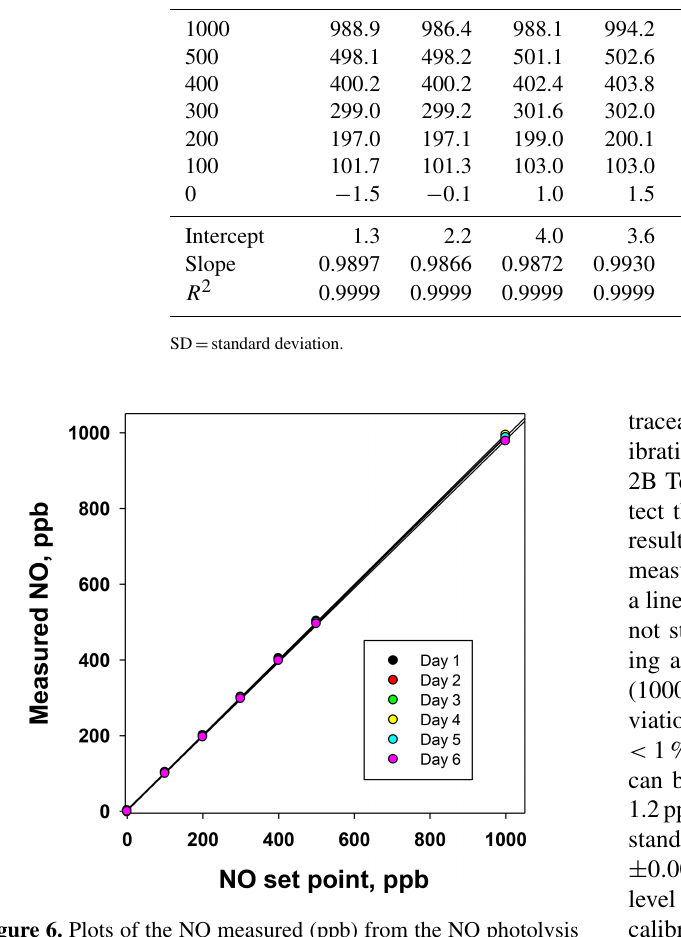
Figure 6. Plots of the NO measured (ppb) from the NO photolysis source of a 2B Technologies Model 714 NO 2 / NO / O 3 Calibration Source vs. the NO set point on six consecutive